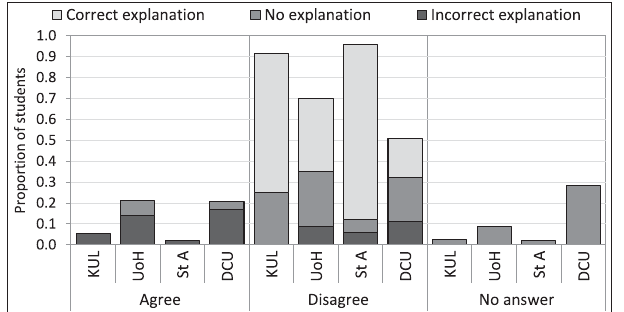
FIG. 9. Distribution of responses and corresponding argumen- tation to question 4(c) [Fig. 1(d)].